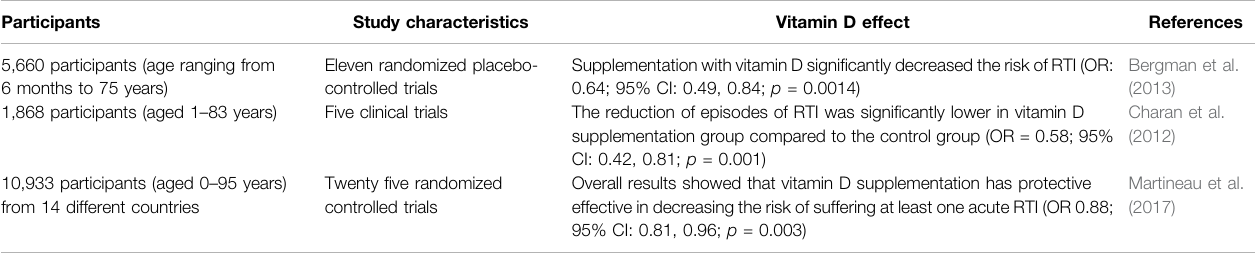
TABLE 2 | The fi nding on the ef fi cacy of vitamin D in the respiratory tract